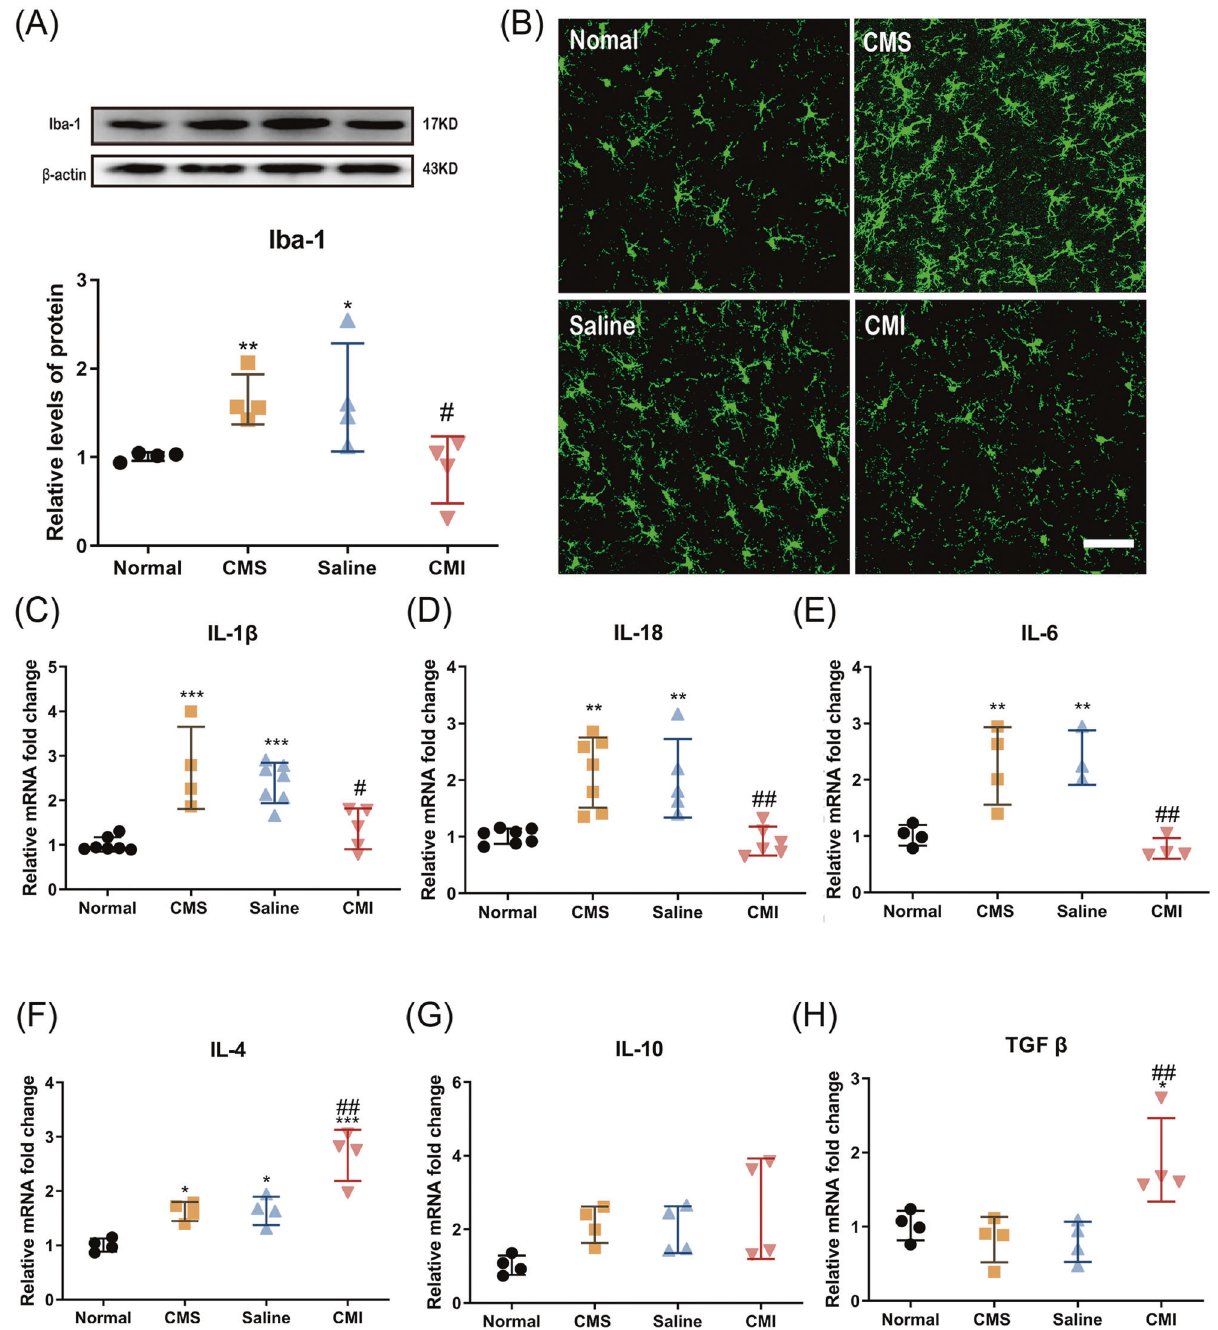
Fig. 2 Chronic clomipramine treatment improved the activated microglia and changes in in fl ammation-related cytokines in rats induced by CMS. A The protein level of Iba-1 was analyzed by western blot ( n = 4/group). B The Iba-1 staining in the dentate gyrus area of the hippocampus. Scale bar, 50 μ m ( n = 4 – 7/group). The mRNA level of C IL-1 β , D IL-18, E IL-6, F IL-4, G IL-10, and H TGF β was analyzed by qPCR ( n = 4/group). All data are expressed as the mean ± SD. # p < 0.05, ## p < 0.01 compared to saline-treated rats. * p < 0.05, ** p < 0.01, *** p < 0.001 compared to non-stressed control